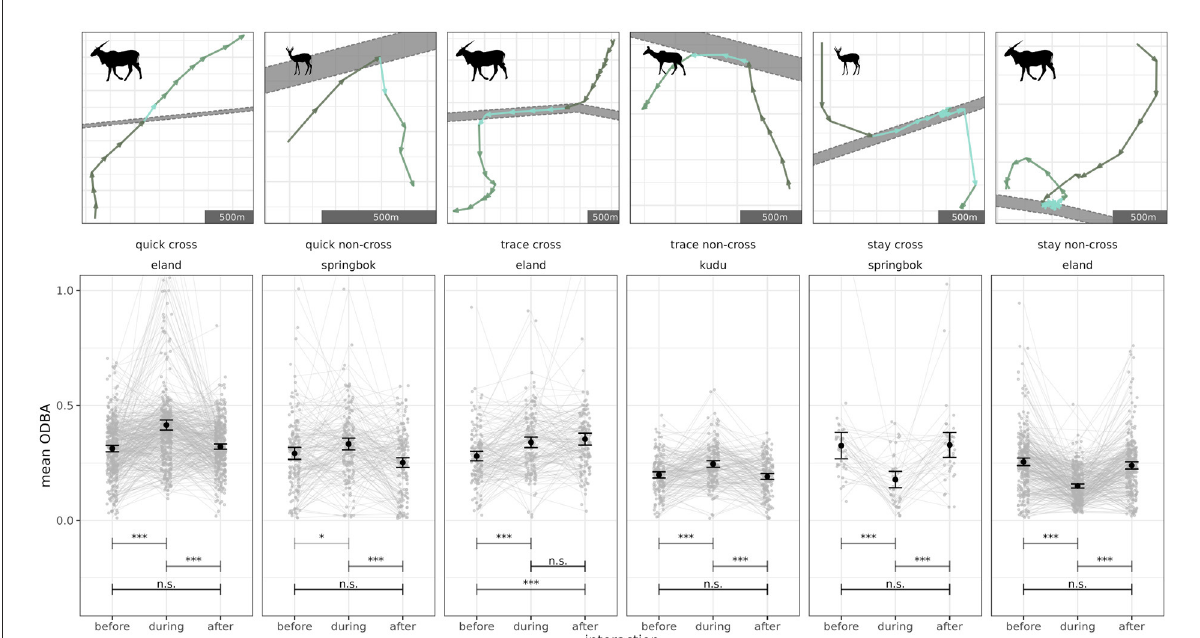
FIGURE4 Impacts of fence interaction on ODBA (overall dynamic body acceleration) as proxy for energy expenditure (selection of results). First row : single example tracks for quick, trace and stay fence interaction types each with cross and non-cross sub-types. Dark green indicates the track before the animal meets the fence, blue green indicates the interaction (during) and light green indicates after the interaction. Movement direction is indicated by arrows. Axes are scaled according to the data (see scale bars). Second row : average ODBA (gray points) of all measurements 45 min before or after the respective fence interaction and during the interaction with each event connected by a line. Overall mean (black points) and standard error (black error bars) shown per before, during or after the interaction sample group. Panels refer to fence interaction type, if the fence was crossed ( cross ) or not crossed ( non-cross ) and the selected species column-wise (see panel titles). y-axis is limited to 1.0 for presentation purposes, plotted data is not. Test significance indicated as ratio between critical p -value of post-hoc test and p -value of post-hoc test with: < 1: n.s. (non-significant); > 1: * ; > 10: ** ; > 100: ***